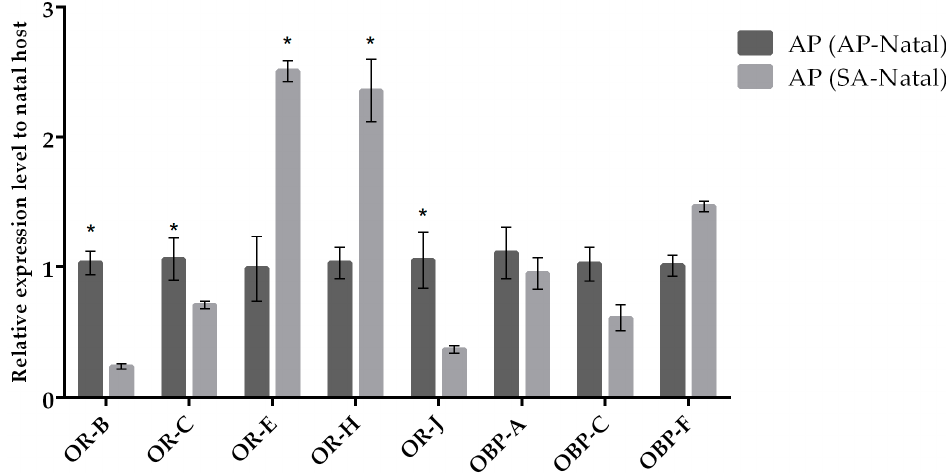
Figure 4. Mean (+/ − SE) mRNA expression levels of ORs and OBPs from the heads of A. ervi maintained on the natal host A. pisum (AP-Natal) or switched from S. avenae to the non-natal host A. pisum (SA-Natal) measured by RT-qPCR. RT-qPCRs were performed using specific primers for each gene. Normalizer gene: RPL19. The asterisk * above the bars indicates significant differences according to two-way ANOVA ( p value < 0.05).